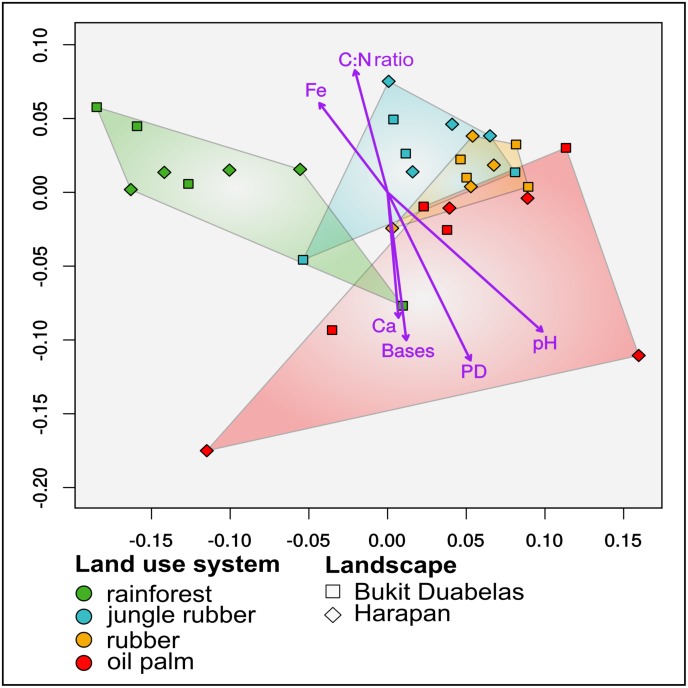
Non-metric multidimensional scaling (NMDS) based on a Weighted UniFrac distance matrix of soil bacterial community composition in all core plots of three converted land use systems (jungle rubber, rubber, and oil palm) and rainforest reference sites in two different landscapes. The detected stress level was 0.1415033 (for details see Supplementary Figure S4). The 96 subplot samples were merged to core plot level previous to calculation of the weighted UniFrac matrix. Purple arrows show significant correlations of abiotic measurements (carbon to nitrogen ratio (C:N), base saturation (bases), pH, calcium (Ca) and iron (Fe) and diversity metric PD (p < 0.05).